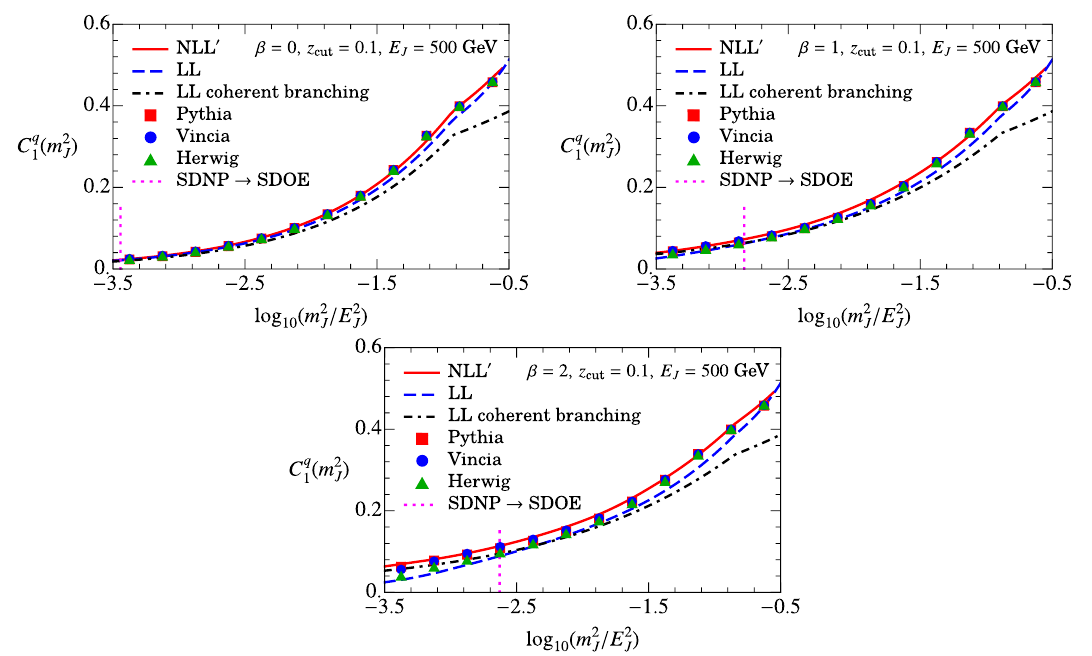
Figure 8 . Comparison between the LL (blue dashed) and NLL 0 (red) effective theory predictions for the perturbative coefficient C 1 , the LL predictions from coherent branching formalism (black dot-dashed) and Monte Carlo simulations (colored markers), for different values of β . The vertical dotted magenta line signals the transition from the SDNP region at small m J to the perturbative SDOE region at larger m J